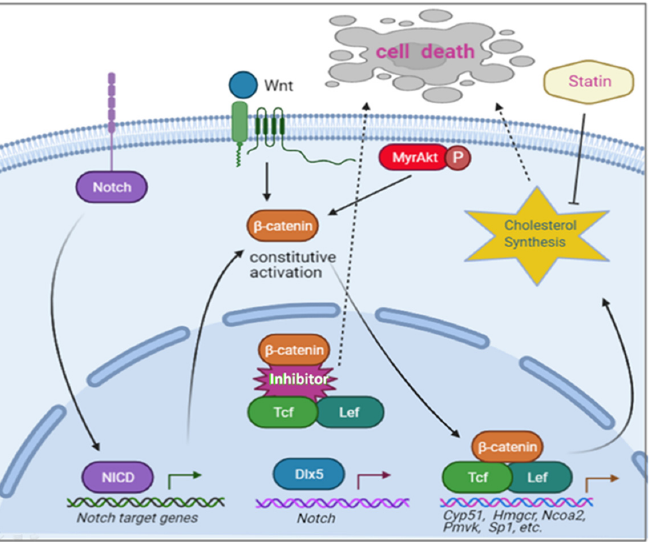
Figure 7. Dlx5 cooperates with activated Akt (MyrAkt) to accelerate T-cell lymphoma in a GEM model. The Wnt pathway was activated when mouse T-cells expressed both Dlx5 and MyrAkt2 transgenes. Inhibition of the β -catenin/Tcf complex resulted in apoptosis. β -catenin/Tcf directly transactivates several key components in the cholesterol synthesis pathway, such as Cyp51 , Hmgcr , and Ncoa2 . The augmented cholesterol synthesis at least partially underlies the oncogenic role of Wnt signaling, as statin treatment triggered cell death in these cells.